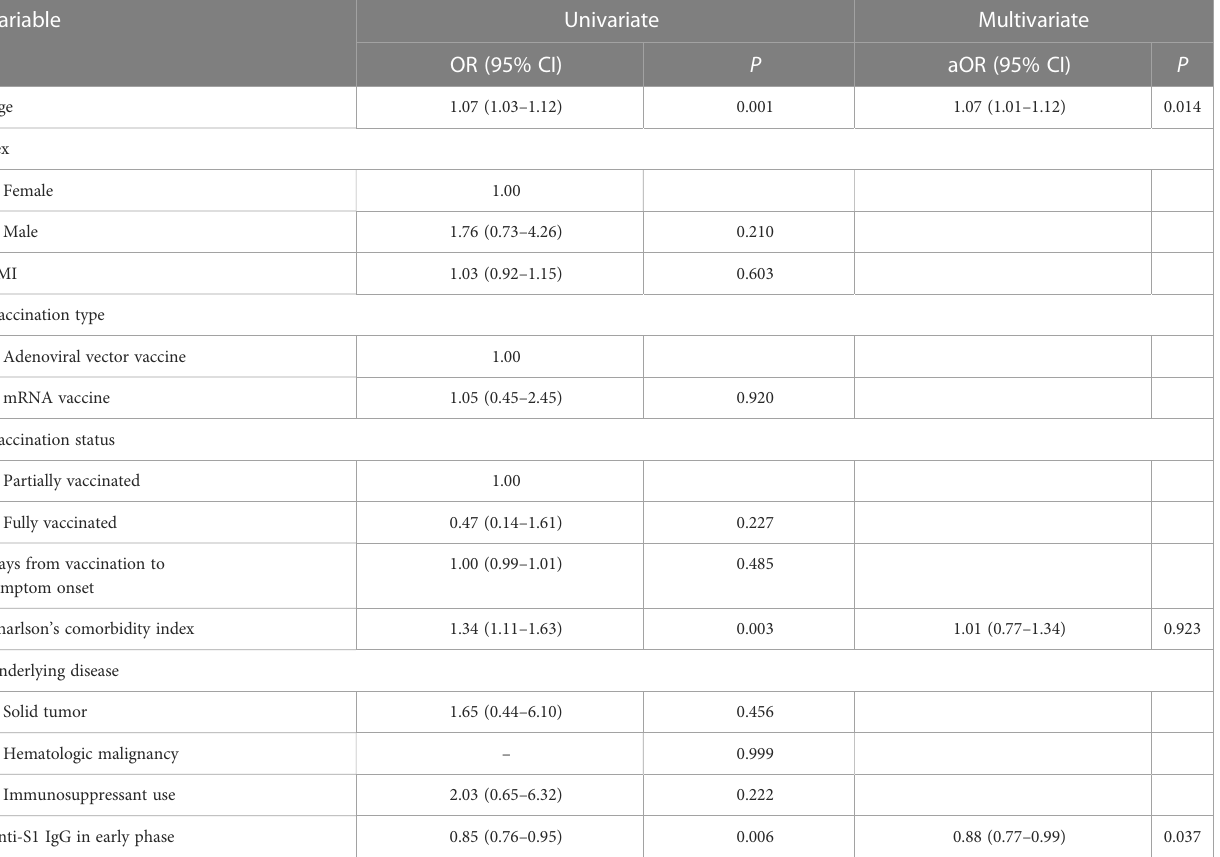
TABLE 2 Risk factors for severe breakthrough